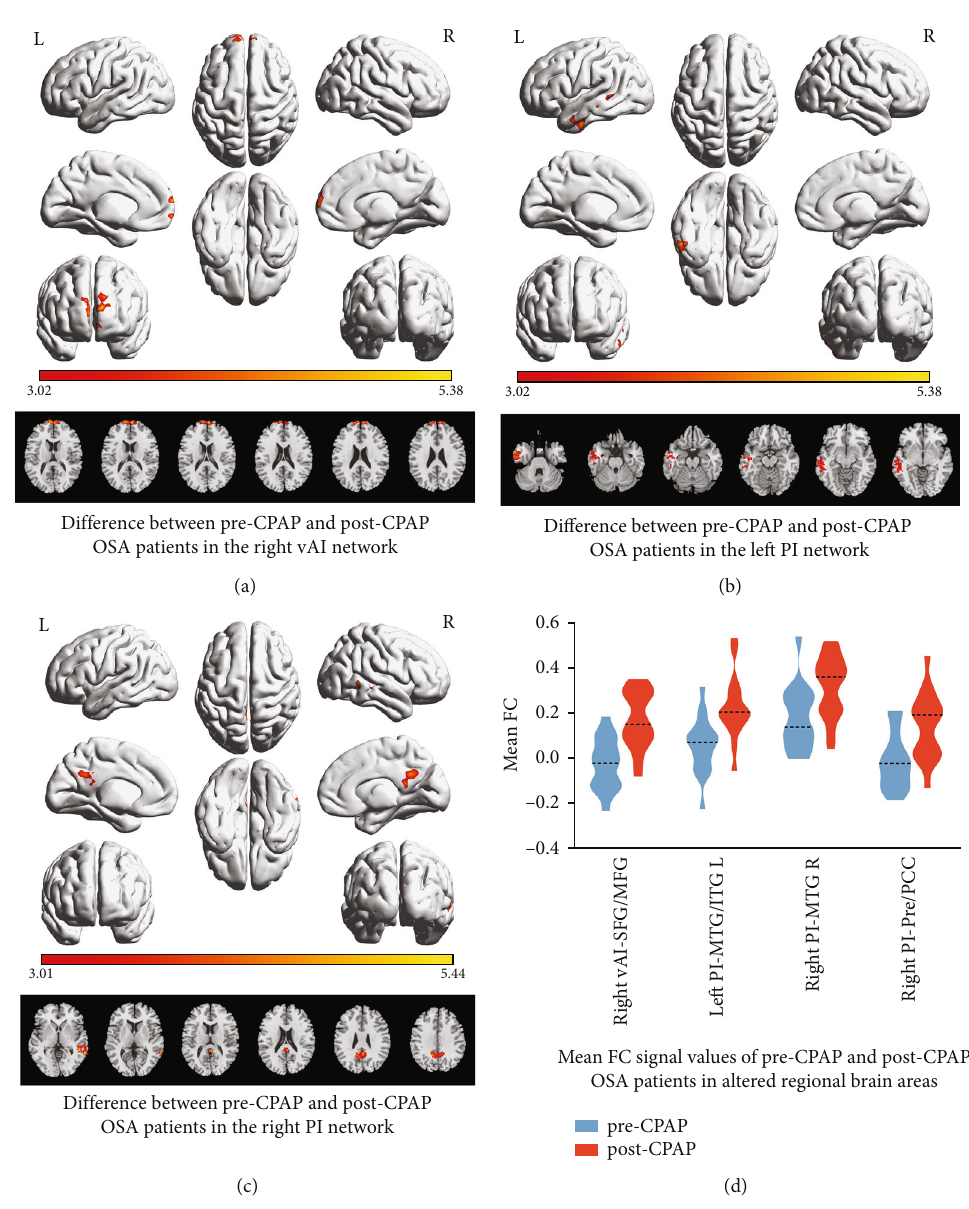
Figure 3: (a) Denotes the FC di ff erence of post-CPAP OSA relative to pre-CPAP OSA based on the right vAI seed. (b) Denotes the FC di ff erence of post-CPAP OSA relative to pre-CPAP OSA based on the left PI seed. (c) Denotes the FC di ff erence of post-CPAP OSA relative to pre-CPAP OSA based on the right PI seed (voxel level p < 0 : 01 , cluster-wise p < 0 : 05 , two-tailed, GRF corrected). (d) Mean FC z signal values of pre- and post-CPAP OSA patients in altered regional brain areas before and after CPAP treatment. Color bars indicate t -scores; warm colors indicate areas where the FC value in pre-CPAP OSA is greater than that in post-CPAP. OSA: patients with obstructive sleep apnea; vAI: ventral anterior insula; PI: posterior insula; FC: functional connectivity; SFG: superior frontal gyrus; MFG: middle frontal gyrus; MTG: middle temporal gyrus; ITG: inferior temporal gyrus; Pre: precuneus; PCC: posterior cingulate cortex; L: left; R: